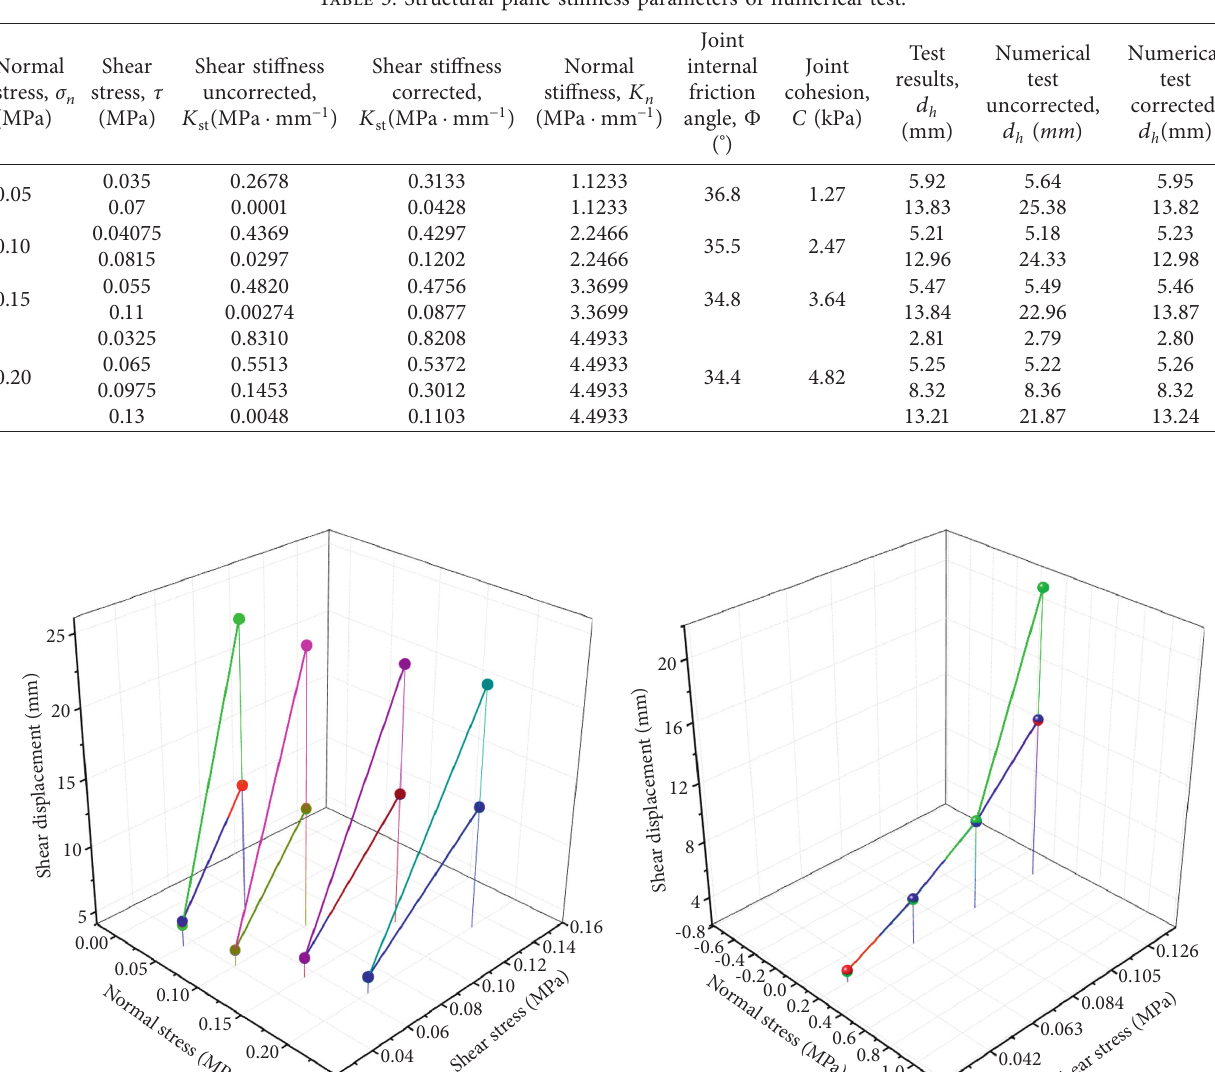
Table 3: Structural plane stiffness parameters of numerical